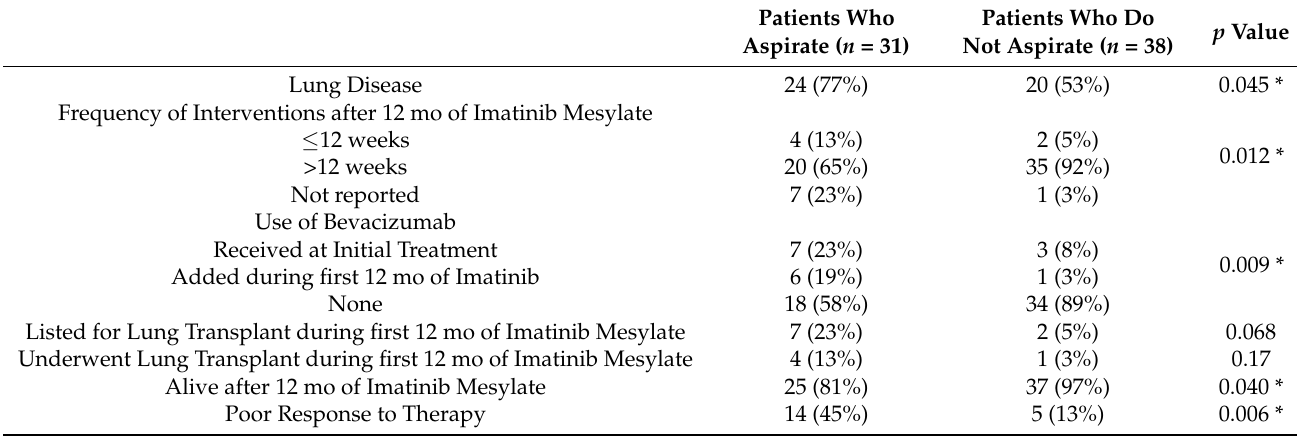
Table 4. Individual Treatment Outcomes for 2-Ventricle Patients.